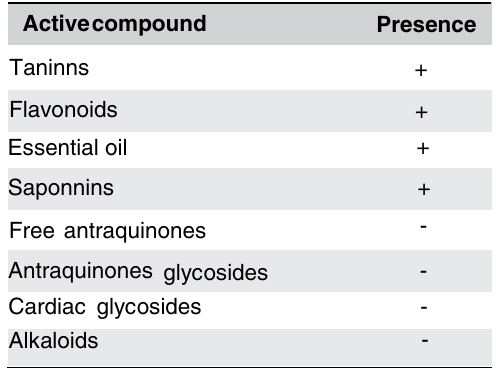
Table 1. Phytochemical analysis of the main groups of active compounds.